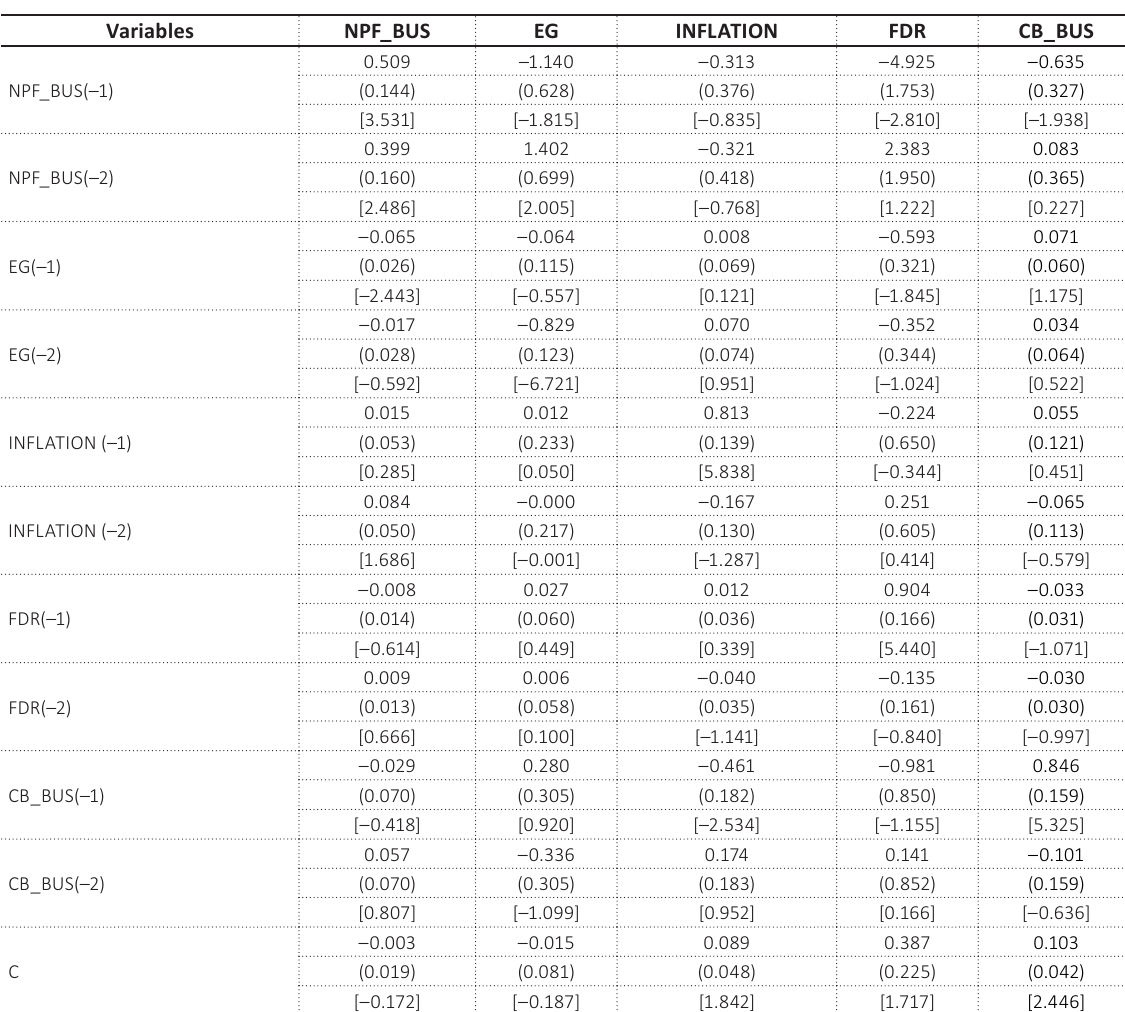
Table A7. VAR estimation result